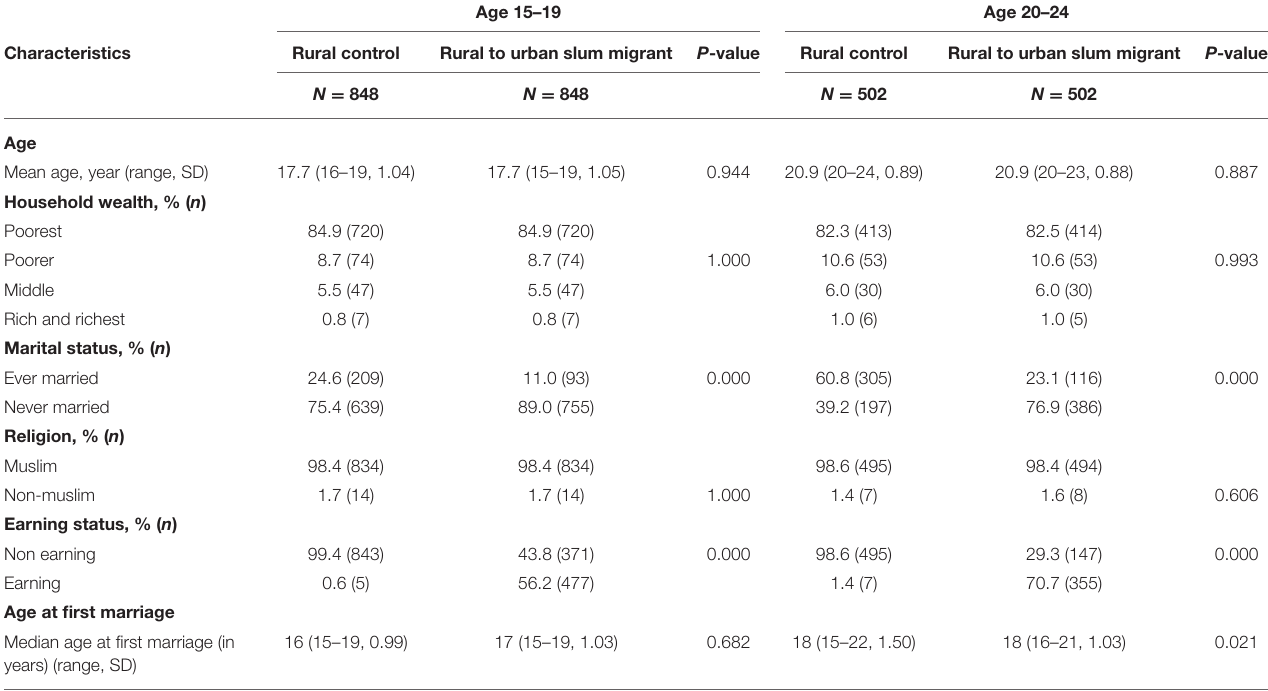
TABLE 1 | Background characteristics of propensity score matched sample by age